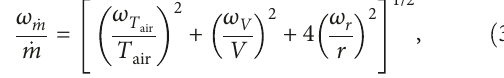
Figure 6: Temperature rise ( T (a) 7 cm, (b) 5 cm, and (c) 3